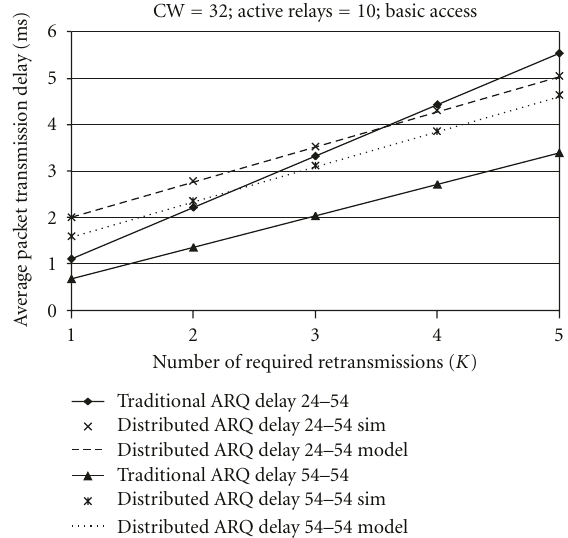
Figure 5: Average Packet Transmission Delay (relay high rate